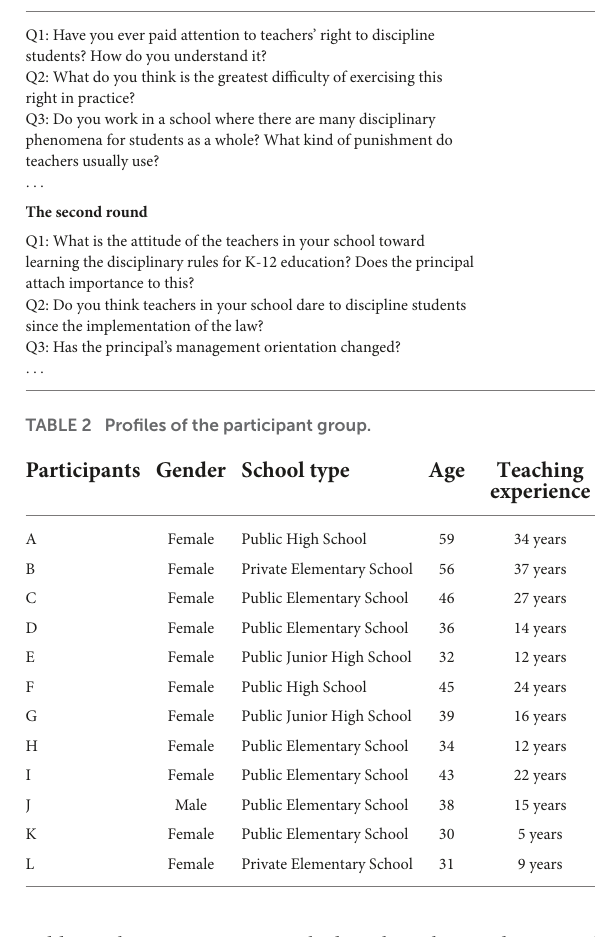
TABLE 1 Sample of the semi-structured interview questions.